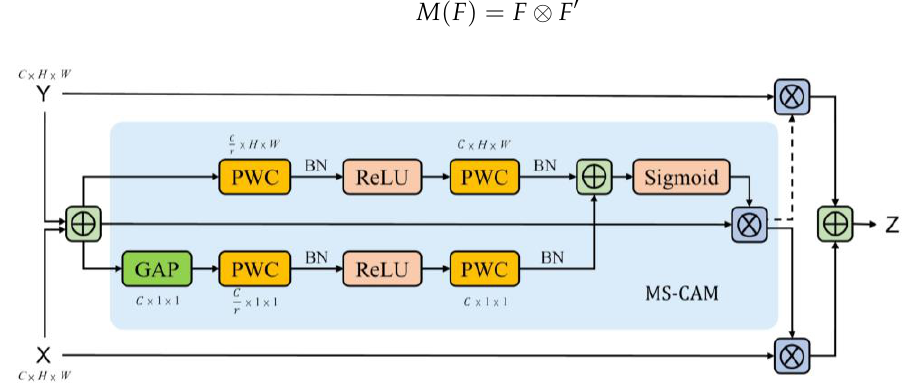
Figure 3. Attention feature fusion: the blue area represents the multiple scale channel attention module, ⊕ denotes the broadcasting addition, and ⨂ denotes the element-wise multiplication.